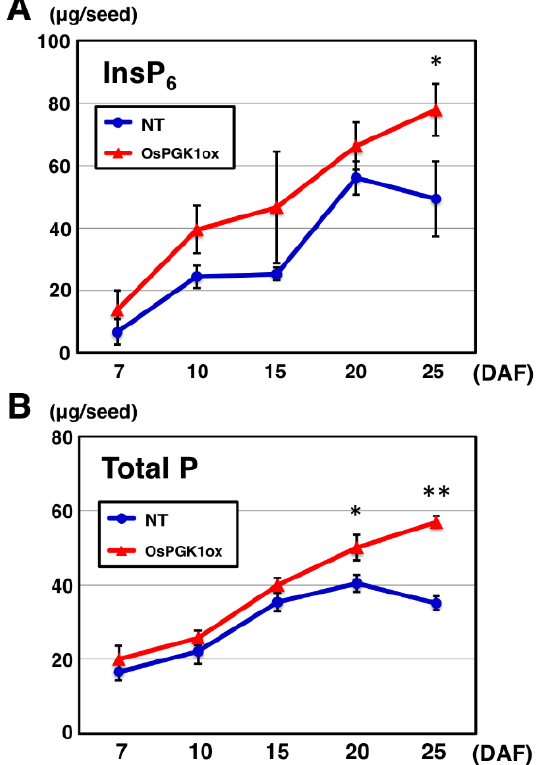
Figure 4. Changes in InsP 6 ( A ) and total P ( B ) content in immature seeds of OsPGK1ox-1 and NT during seed development from 7 to 25 d after flowering (DAF). InsP 6 and total P contents were determined by ion chromatography and ICP-OES analyses,